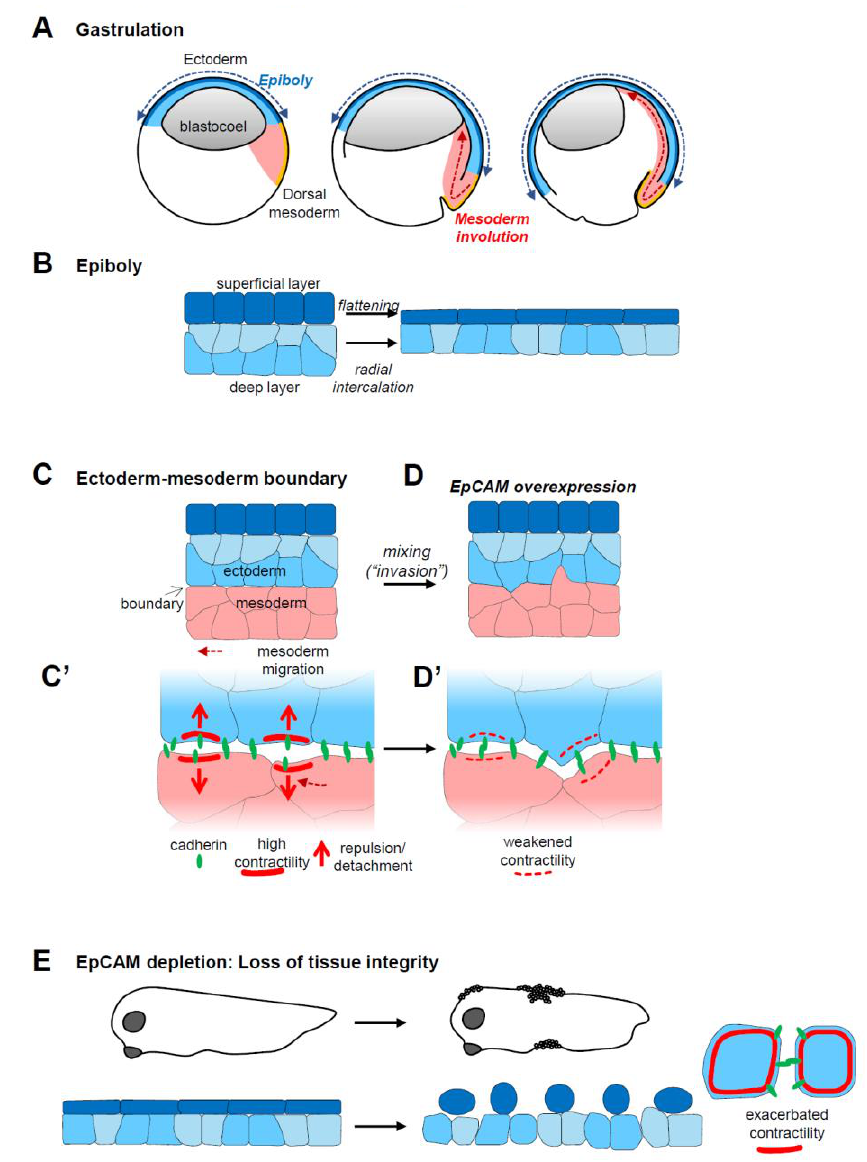
Figure 1. EpCAM gain-of-function and loss-of-function embryonic phenotypes. ( A ) Diagram of three consecutive stages of Xenopus gastrulation, indicating the movement of ectoderm epiboly (blue) and of mesoderm involution (red). ( B ) Epiboly involves two morphogenetic movements: The cells of the superficial layer flatten, while the cells of the deep layer rearrange by radial intercalation to rearrange into a single layer. The combined action of these two movements results in a large expansion of the surface of the ectoderm, which, at the end of gastrulation, covers the entire embryo. ( C ) The ectoderm and mesoderm are kept separated by a sharp interface, a so-called embryonic boundary. The mesoderm migrates along the surface of the ectoderm, using ectoderm cells as substrate for adhesion. ( C’ ) The boundary results from ephrin-Eph-mediated repulsive reactions that locally boost actomyosin contractility, which leads to local and transient detachments of cadherin adhesions across the boundary. Through alternate attachments and detachments, mesoderm migration can proceed without intermingling with the ectoderm. ( D ) High EpCAM expression decreases actomyosin contractility, perturbing the function of the boundary. This results in mixing between the ectoderm and mesoderm layers, blocking mesoderm involution. ( D’ ) At the cellular level, reduced contractility abolishes repulsive reactions, favouring intimate adhesive contacts between the two tissues, and eventually leading to their intermingling. ( E ) EpCAM depletion leads to massive loss of tissue integrity, due to uncontrolled contractility that results in cells’ rounding up and